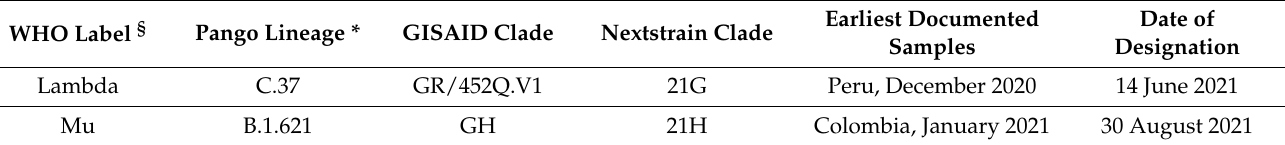
Table 4. Currently designated Variants of Interest (VoI)